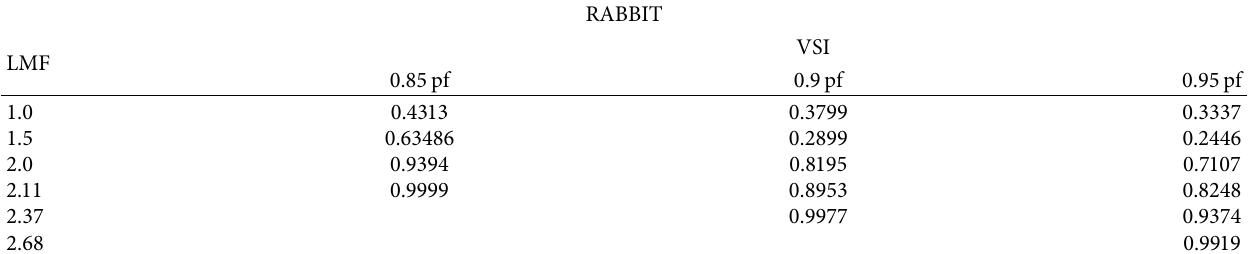
Table 6: Stability points of the RABBIT conductor.